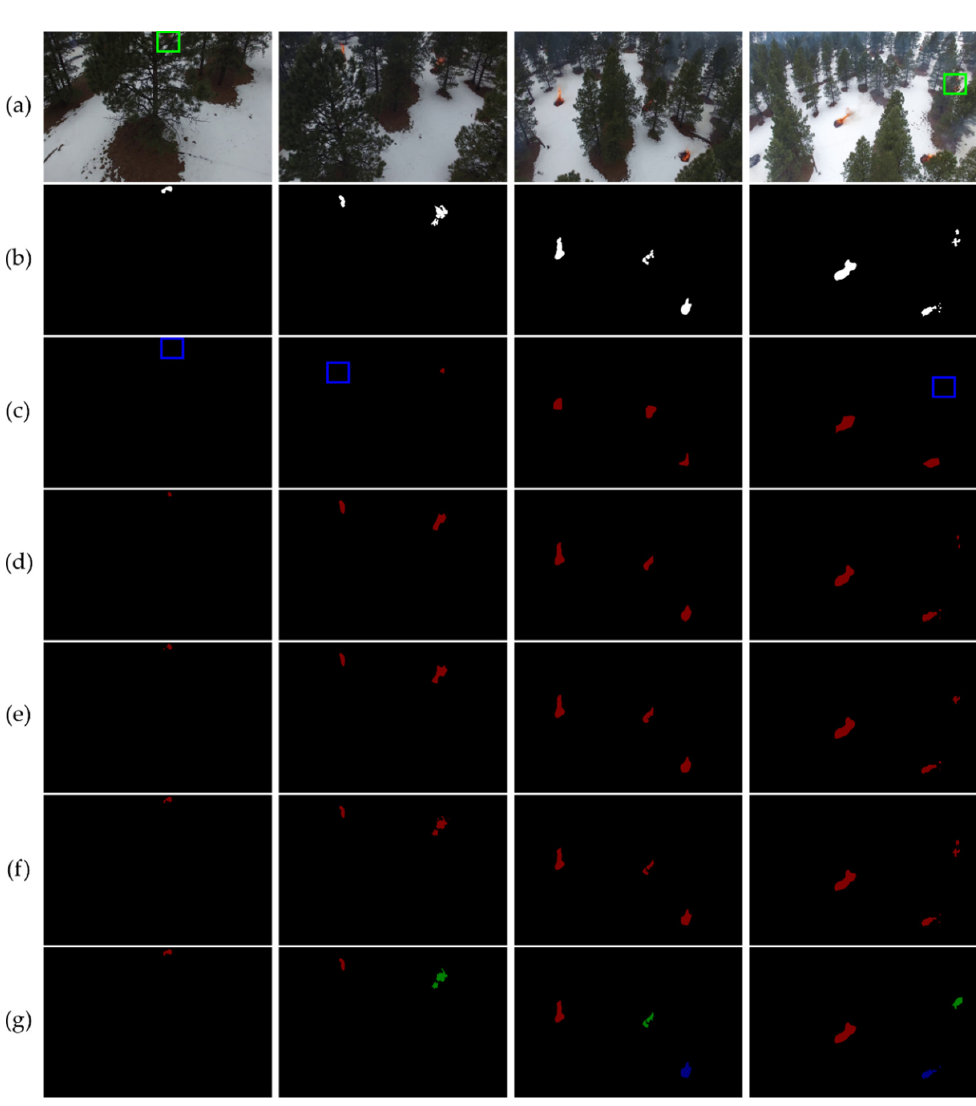
Figure 10. Results on testing images. ( a ) Raw images and ( b ) ground truth labels. Segmented results by ( c ) SegNet, ( d ) UNet, ( e ) PSPNet, ( f ) DeepLabv3, and ( g ) our MaskSU R-CNN.